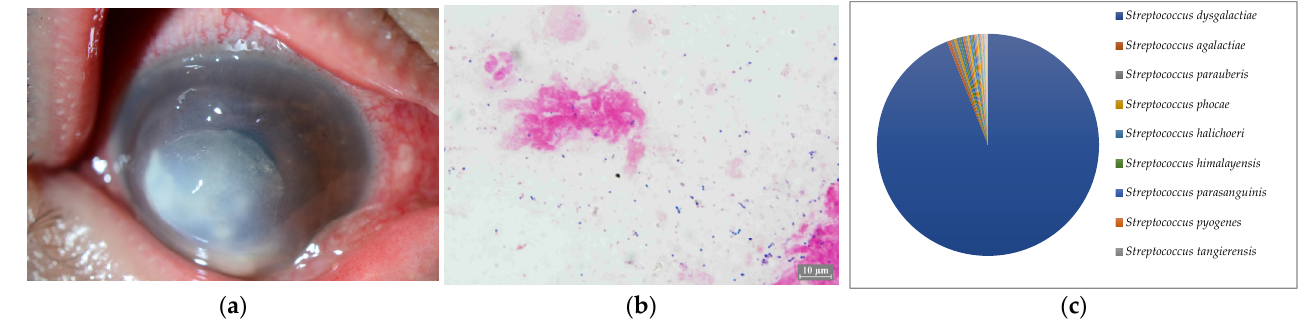
Figure 3. ( a ) Anterior segment photograph. The entire cornea has pale opacity and hypopyon is obvious. ( b ) Smear microscopy. Elongated Gram-negative rods were detected. ( c ) Nanopore sequencing results (relative abundance) of Case 3. ( c ) An overwhelming majority of Pseudomonas aeruginosa was detected by MinION.